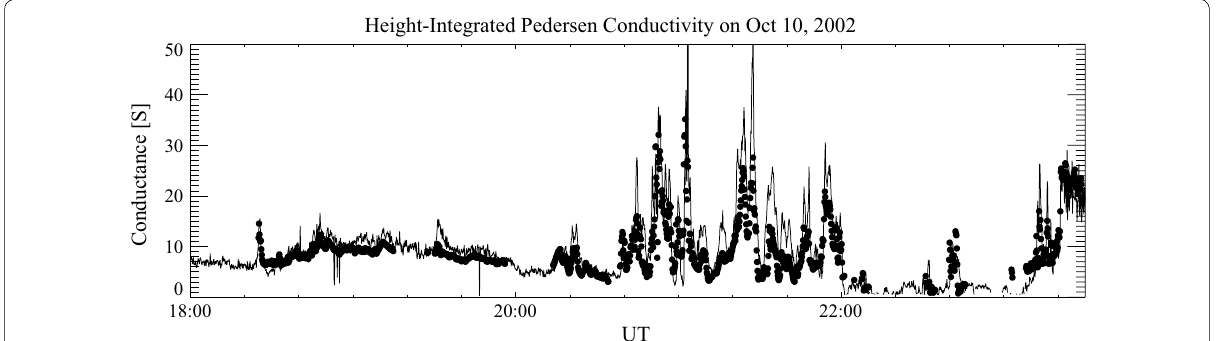
Fig. 15 Temporal variations of the corrected height-integrated Pedersen conductivities for October 10, 2002; temporal variations of the height-inte- grated Pedersen conductivities derived with the EISCAT UHF radar and the photometer observations between 18:00 UT and 23:30 UT on October 10, 2002. The photometer data are corrected with the correction values of the atmospheric scattering